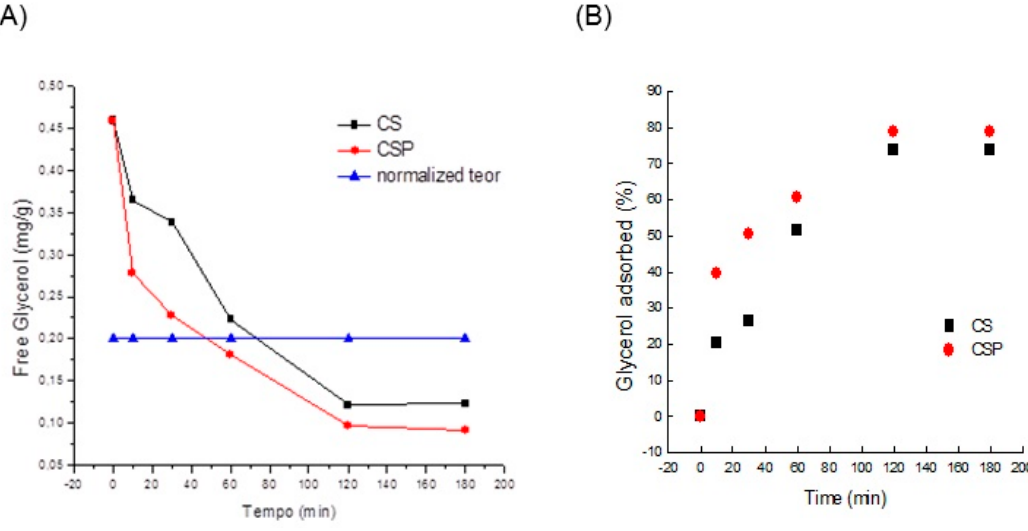
Figure 6. Influence of adsorption time on glycerine removal by CS and CSP. ( A ) Concentration of glycerol in biodiesel and ( B ) percentage of glycerol removed from biodiesel.